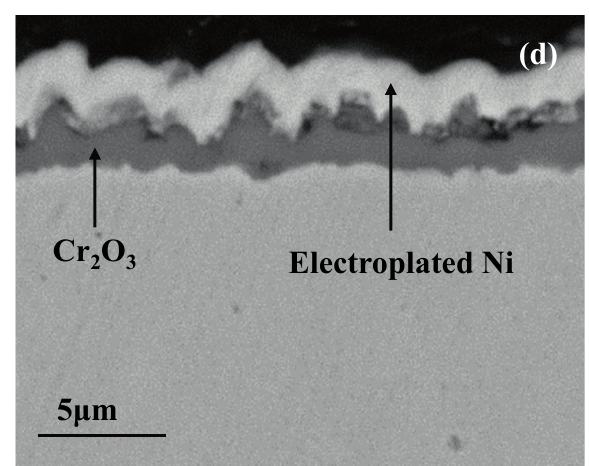
Figure 4. Scale microstructure of PMFe-40Ni-15Cr and MA Fe-40Ni-15Cr alloys oxidized at 1173 K in 1:01 (cid:2) 10 2 kPa pure oxygen for 24 h: (a) PMFe-40Ni-15Cr and (b)